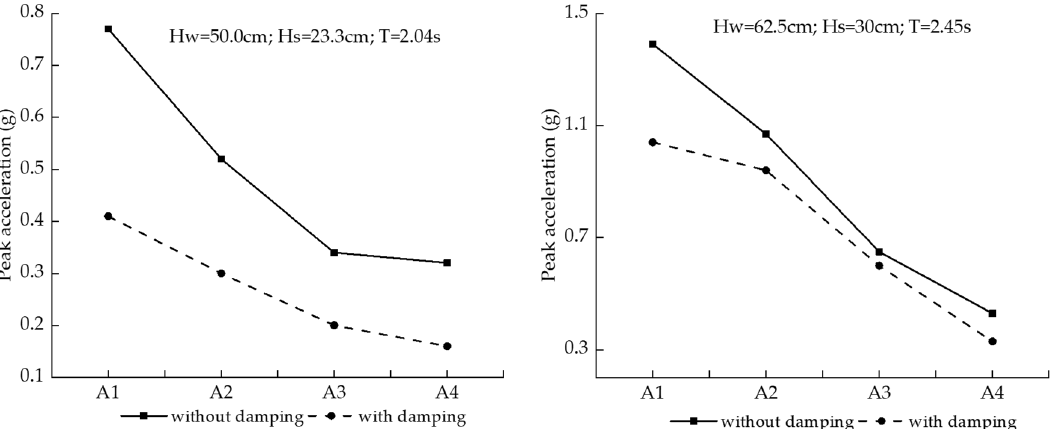
Figure 18. Comparison diagram of acceleration at the monitoring points on the tower with and without the damping device (wave propagation direction).